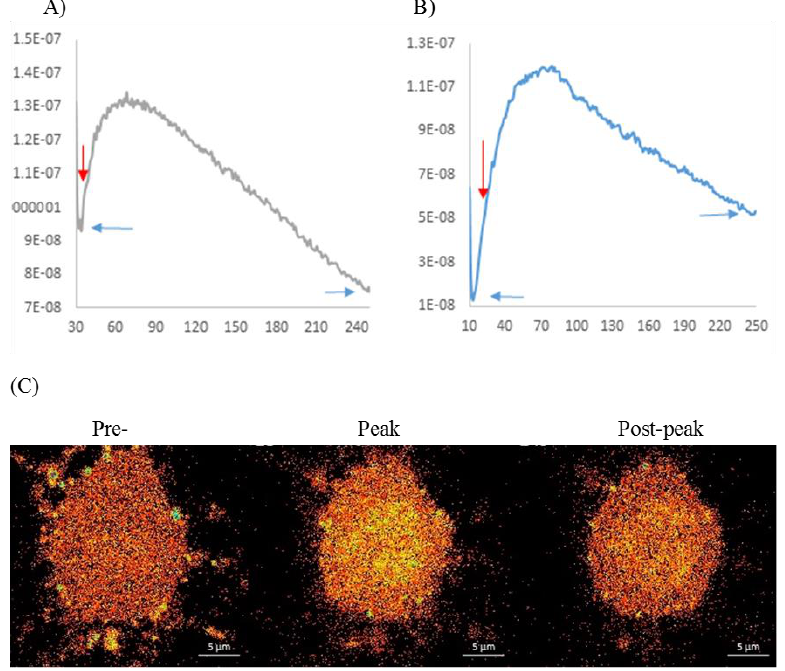
Figure 2. Effects of M. piperita essential oil on Calcium mobilisation in differentiated CAD cells. M. piperita essential oil (0.1 mg/mL) was applied (red arrow) and recorded for 250 cycles. Representative of at least 5 cells from 3 separate experiments. ( A ) Positive modulation on calcium intracellular mobilisation. A rapid increase in calcium was observed in the neuronal cell body, which peaked approximated cycle 40 post-application (approx. 30 s) and then dropped steadily to a level below the original starting concentration at cycle 250. ( B ) Extension of depolarization — induced calcium